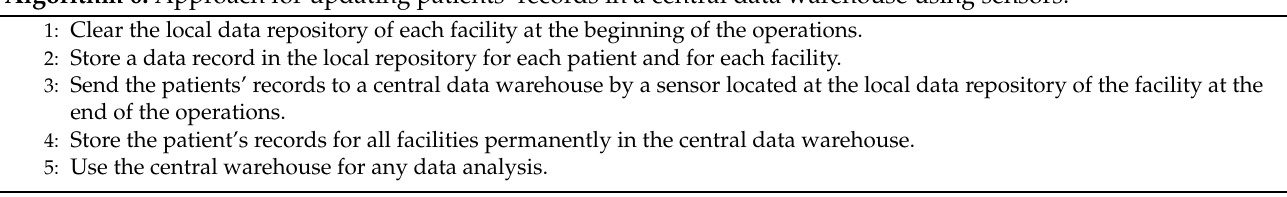
Algorithm 6: Approach for updating patients’ records in a central data warehouse using sensors.